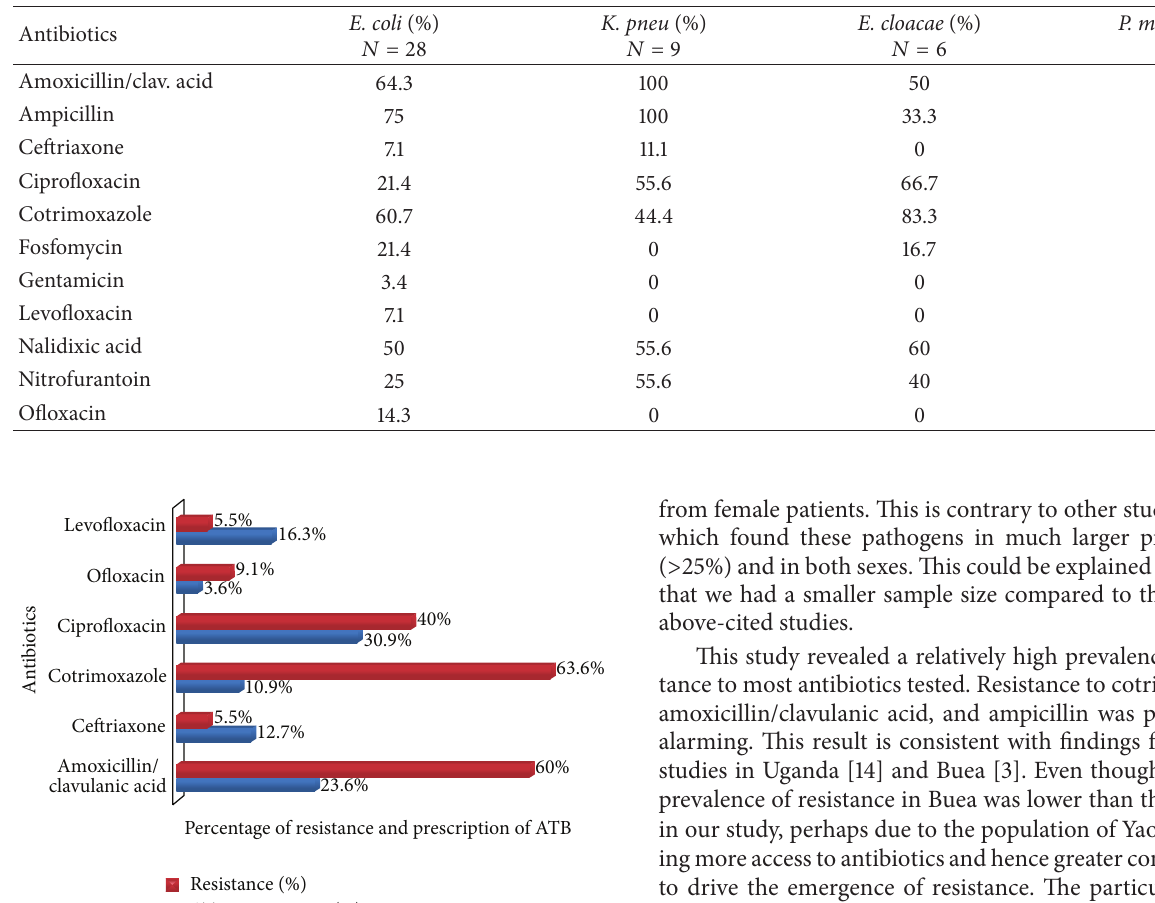
Table 2: Prevalence of antibiotic resistance among the predominant isolates.